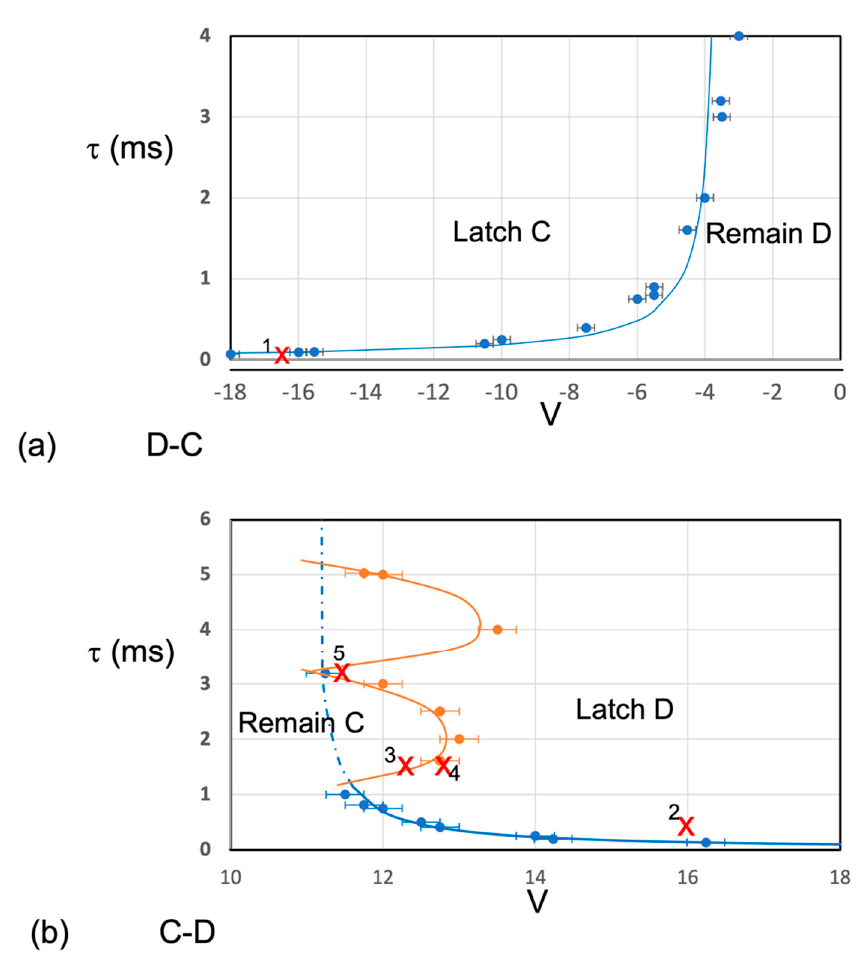
Figure 9. Modelling τ V data for a 5 µ m cell with strong anchoring, W θ = 2.8 × 10 − 4 N/m for ( a ) the D-C transition and ( b ) the C-D transition. The error bars indicate the difference from the lowest magnitude voltage tested which latched and the highest magnitude voltage that did not latch. Each data point represents halfway between these values calculated. The blue lines represent the best fits to Equation (5) with the parameters listed in Table 3. The fit for the C-D latching threshold includes the point at (11.2 V, 3.2 ms) but the fit is shown as a dotted line in this region, since there was no latching immediately above. The orange points at 1.6 ms, 2.5 ms, and 5 ms represent the anomalous latching, with the orange lines guides for the eye only. The five points studied in more detail are indicated by red crosses.